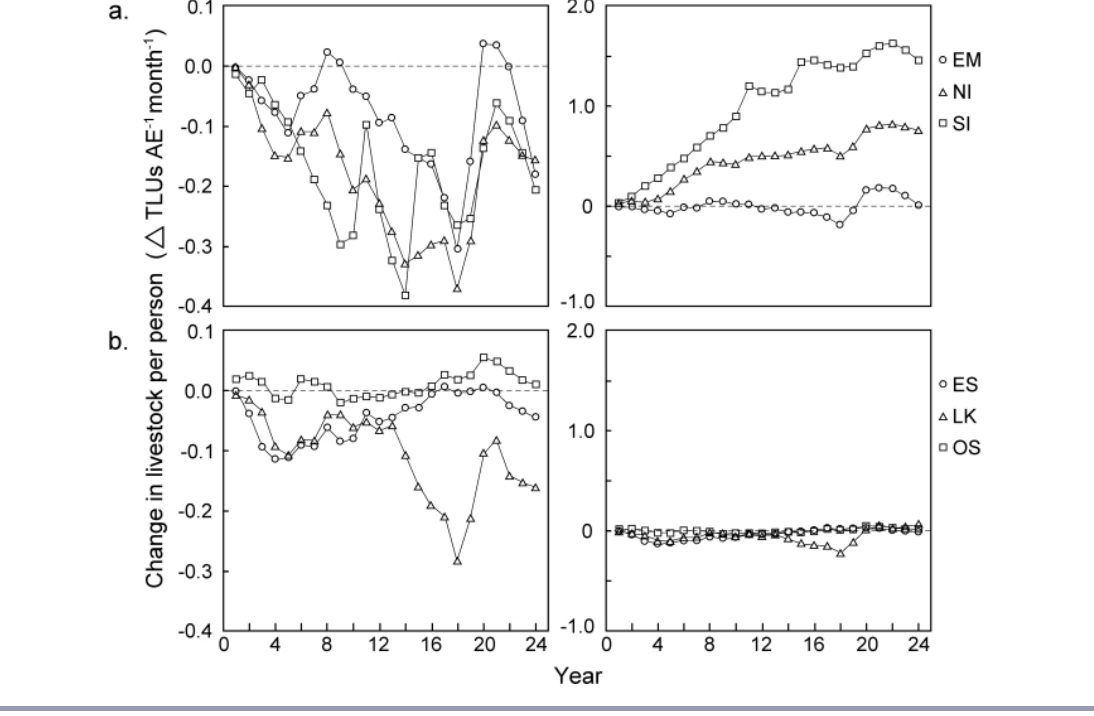
Fig. 6 . Changes in livestock per person, using standardized metrics, when livestock herders were unable to access the Chyulu Hills (left panels), and when access to the Chyulu Hills was not available but herders in neighboring group ranches were compensated for the leased land (right panels). Changes in three areas are shown in rows “a” and “b”, divided only for visual clarity. Row “a” includes Emeshenani (EM, circles), Northern Imbirikani (NI, triangles), and Southern Imbirikani (SI, squares). Row “b” includes Eselenkei (ES, circles), Linkisim (LK, triangles), and Osilalei (OS,